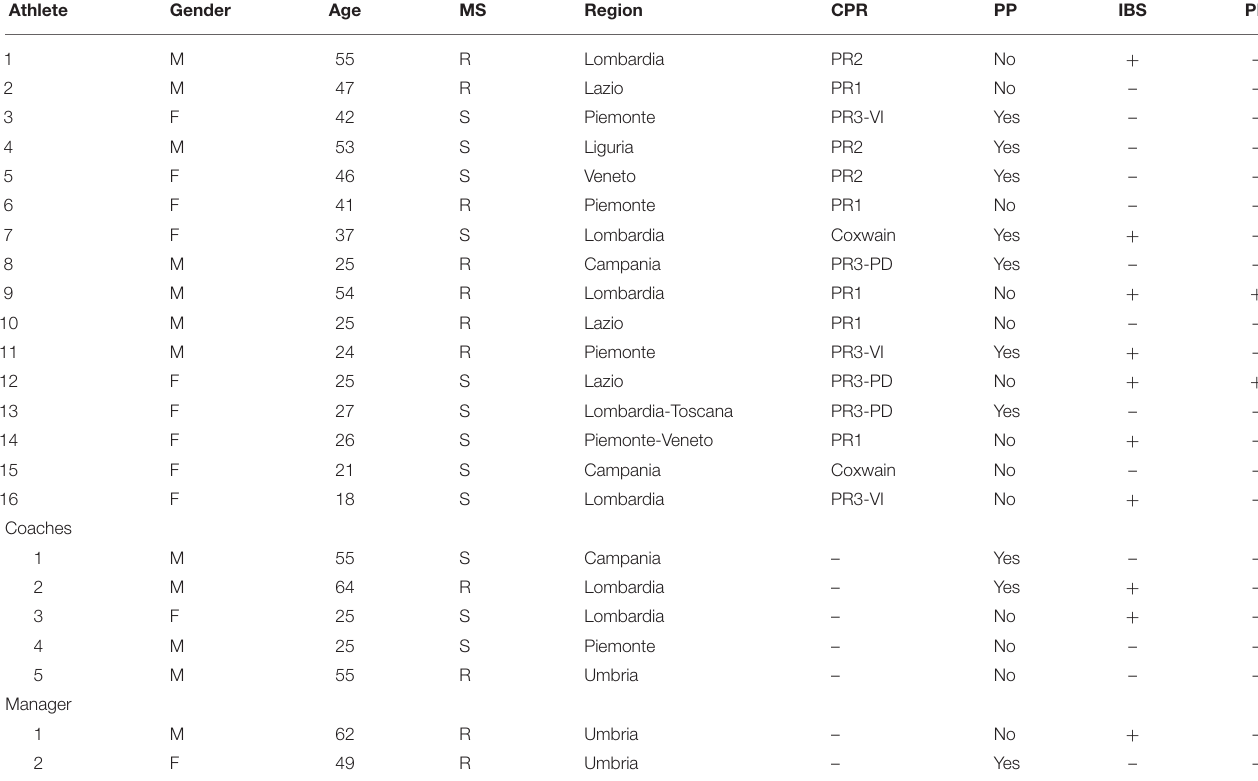
TABLE 1 | Descriptive data of protocol participants and their residential region in Italy.